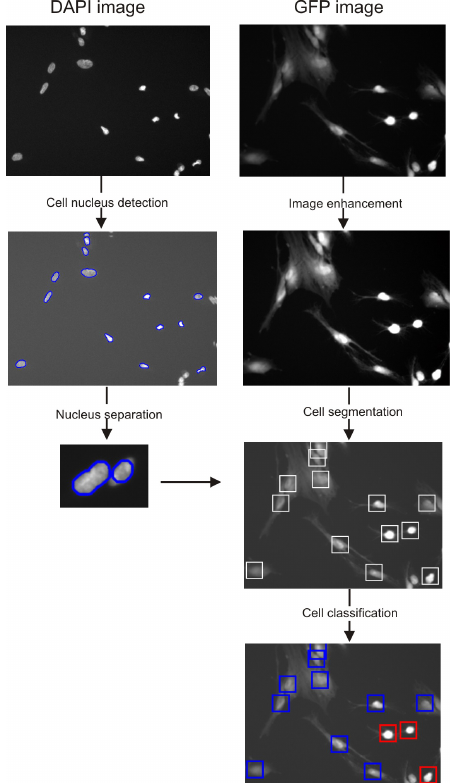
Figure 4. Fundamental steps of the analysis algorithm. For each set of images, a DAPI and a GFP image is preprocessed and analyzed. (1) Original DAPI and GFP images are enhanced. (2) Cell nuclei are detected and separated from each other. (3) Based on the position of nuclei, the cells are segmented in the GFP images. (4) Based on the segmented area, each cell is analyzed and classified as adherent (blue) or rounded (red).